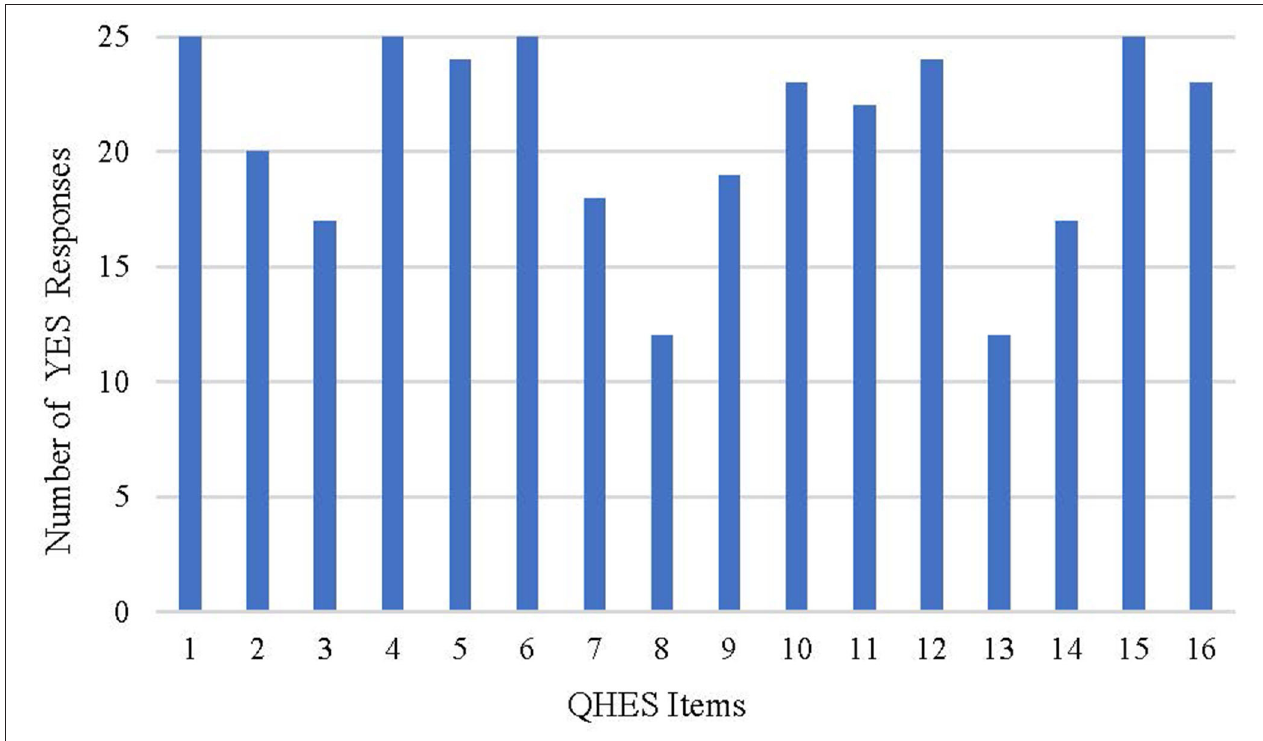
FIGURE 2 | Results of the assessment with the QHES